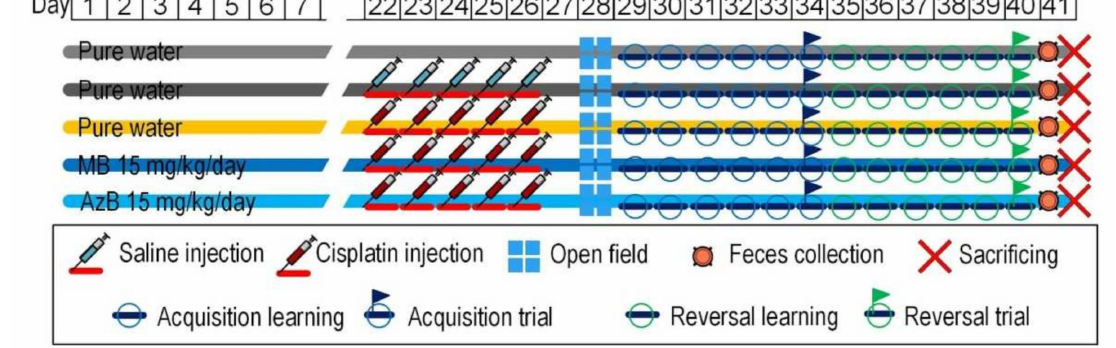
Figure 9. Design of